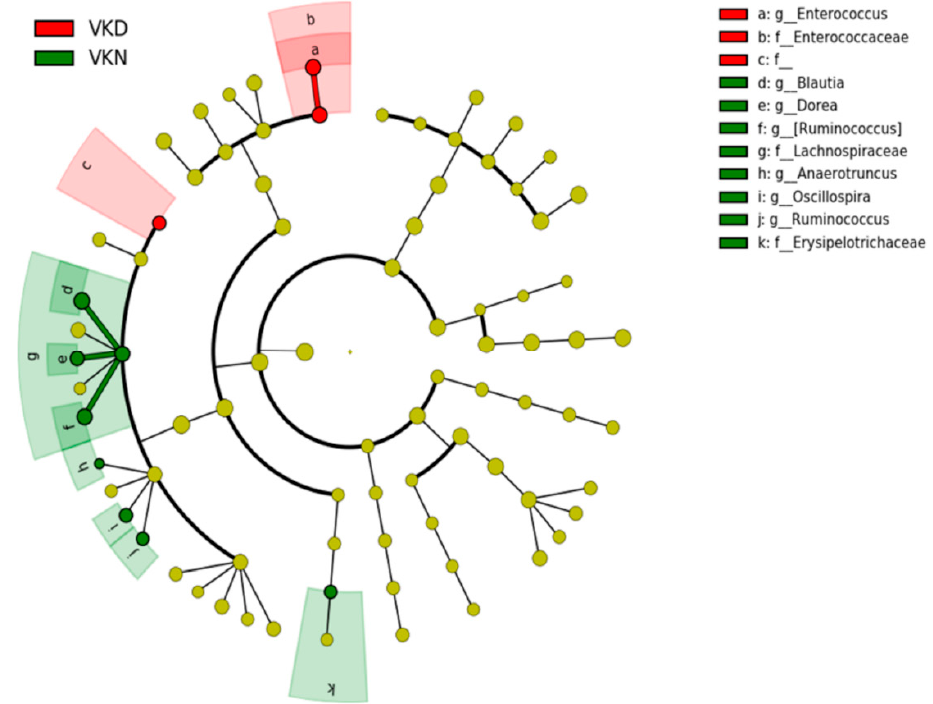
Figure 9. Gut microbiota at the genus level in the vitamin K-satisfactory state. Abundant gut microbiota at the genus level were highlighted on the phylogenetic tree using the GraPhlAn software. Colors distinguish between vitamin K-normal group (green) and vitamin K-deficient group (red), and the intensity reflects the linear discriminant analysis (LDA) score. The size of the nodes correlates with their relative and logarithmically scaled abundances. VKN, vitamin K-normal group; VKD, vitamin K-deficient group; c: f__, c: order__ Clostridiales ; family__; f_, family; g_,